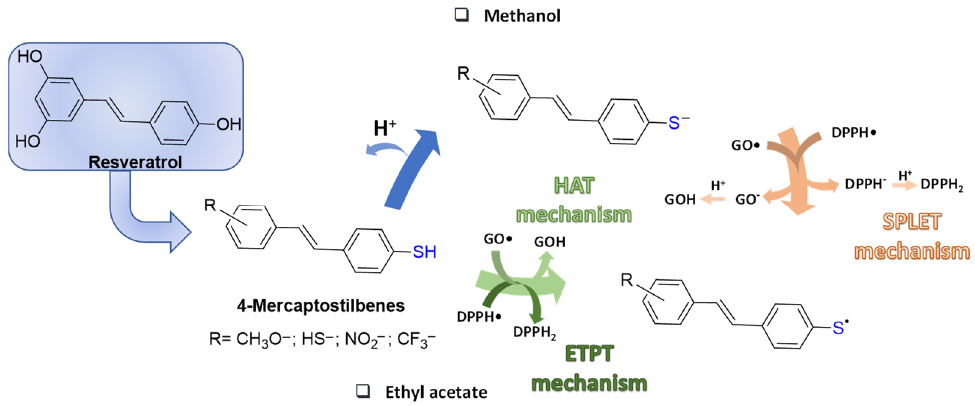
Figure 2. Resveratrol-related 4-mercaptostilbenes and their radical scavenging mechanisms.